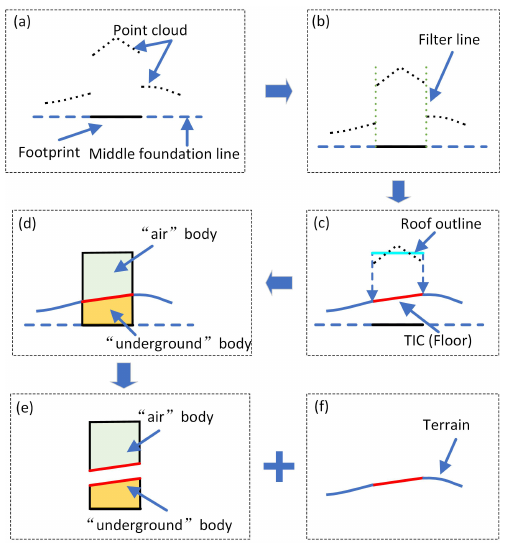
Figure 5. The process of modelling based on footprint and point cloud.